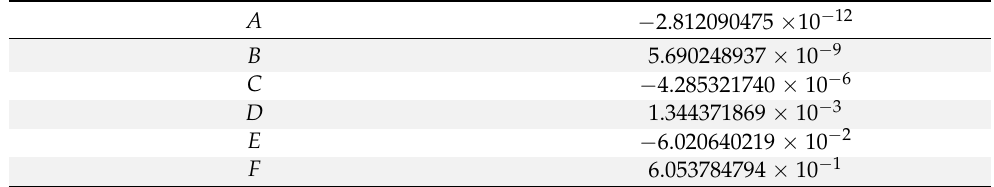
Table 1. Coefficients for Equation (1) for the temperature range 50 K to 600 K, SiC (J/mol/k).